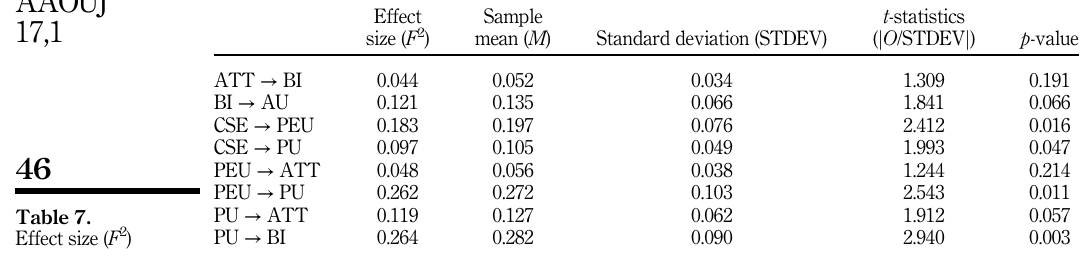
Table 7. Effect size ( F 2